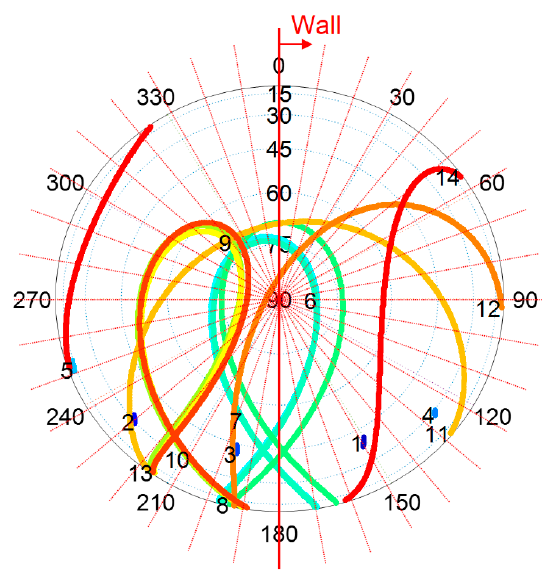
Figure 13. Searching for the azimuth of the Weather Wall in steps of 10°. The skyplot of the simulated location over the simulated day is for BeiDou Navigation Satellite System (BDS).